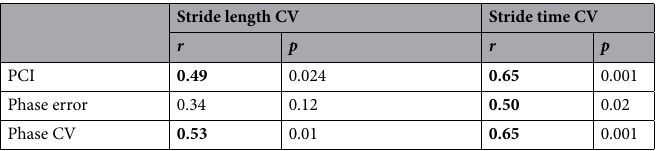
Table 2. Pearson’s bivariate correlations showing the relationship between phase coordination index (PCI), phase error, and coefficient of variation (CV) of phase and gait variability measures in the stroke group. Significant r values are in bold.